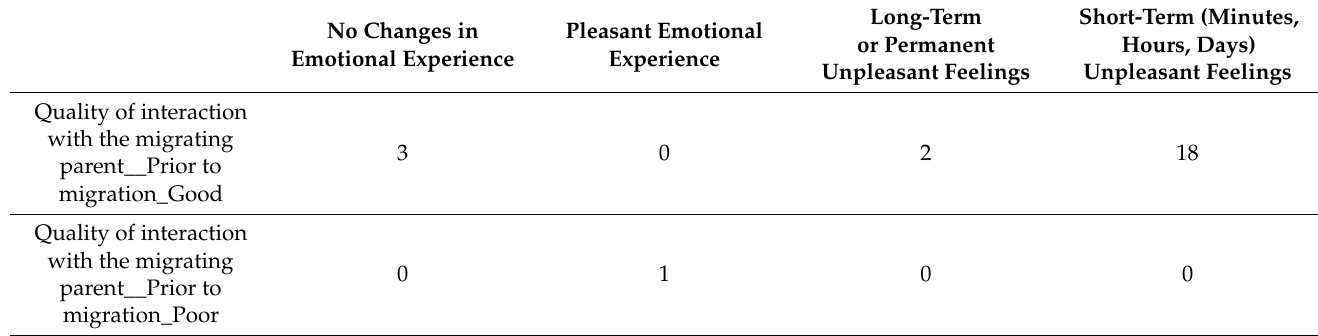
Table A1. Emotional changes on the children by quality of interaction with the migrating parent(s) prior to